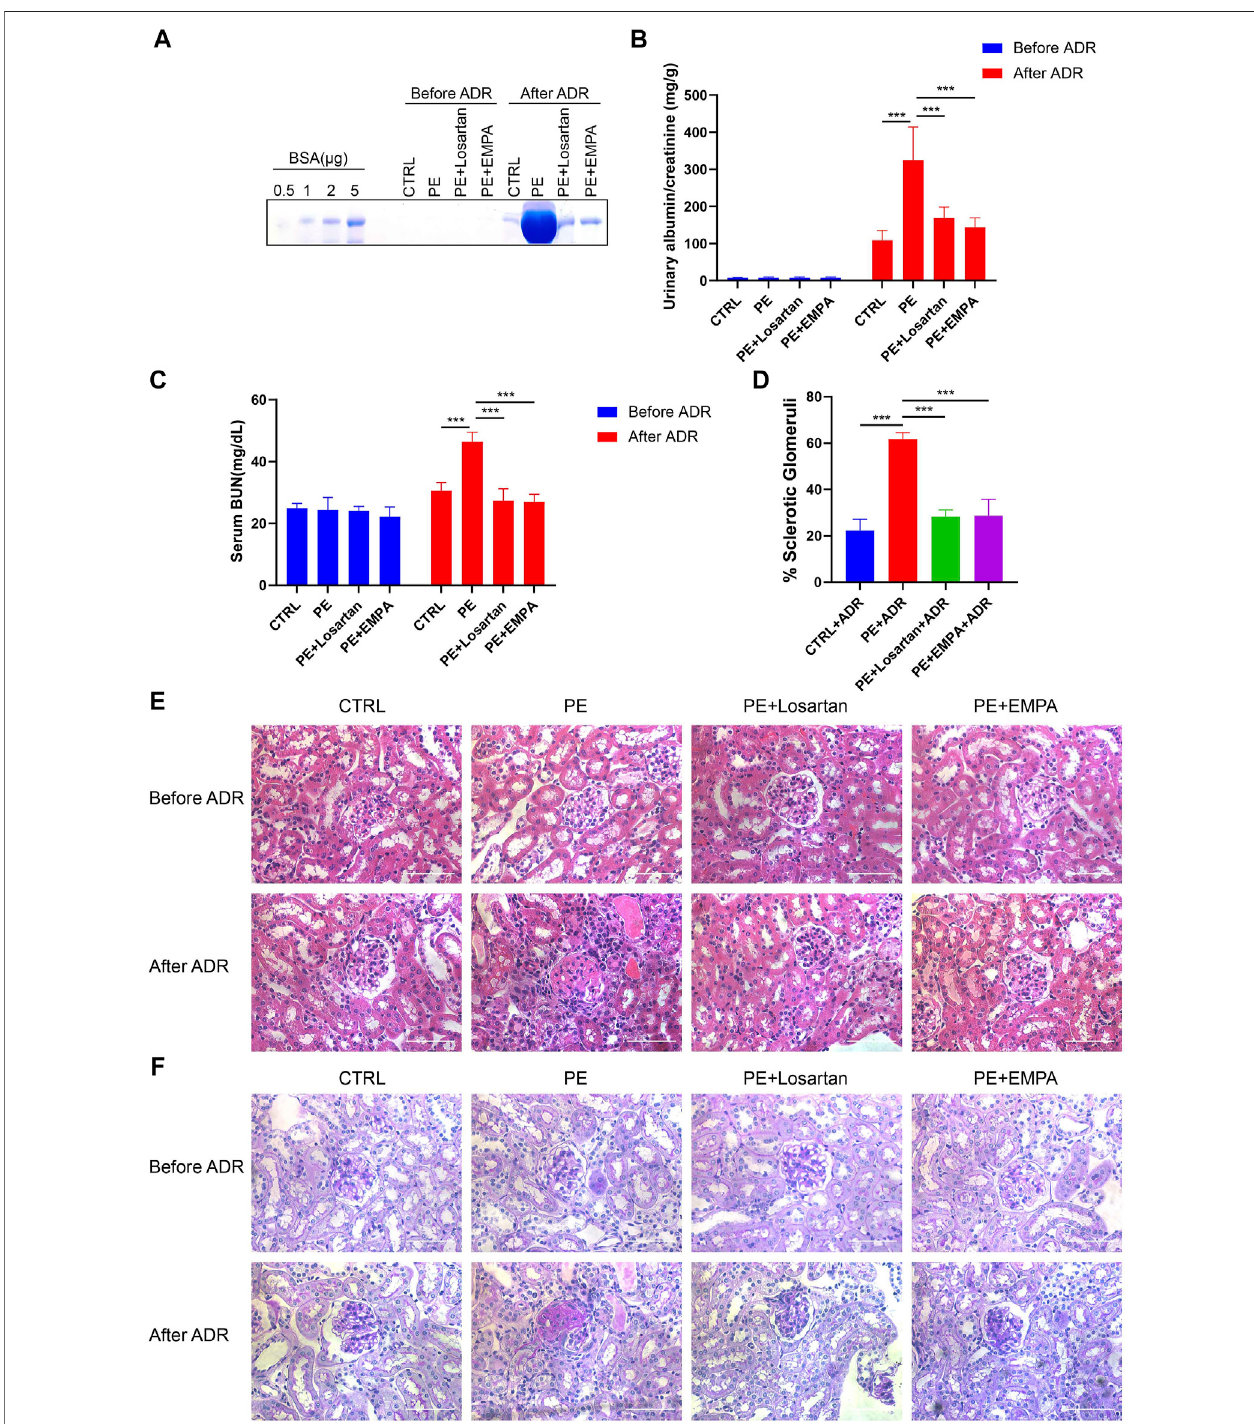
FIGURE8| EMPAtreatmentduringpregnancylimitedthepostpartumrenalinjuryresponse toADRinAT1-AA-injected maternalmice. (A) SDS – PAGECoomassie bluestainingofbovineserumalbumin(BSA)standardsandurinefrompostpartummicebeforeandafterADRinjection,demonstratingproteinuriainthesemice;16 μ Lof each urine sample was loaded. (B) Quanti fi cation of urinary ACRs of postpartum mice before ( n = 9) and after ADR ( n = 6) injection. (C) Serum BUN levels of PE mice before ( n = 3) and after ADR ( n = 6) injection. (D) Quanti fi cation of the percentage of sclerotic glomeruli in PE mice 4 weeks after ADR injection ( n = 3). (E) RepresentativeH&Estainingand (F) PASstainingofkidneysectionsinpostpartummicebeforeandafterADRinjection(scalebarrepresents50 μ m).Dataareexpressed as the mean ± SEM and were analyzed by ANOVA with LSD post hoc test. * p < 0.05, ** p < 0.01, *** p < 0.001.